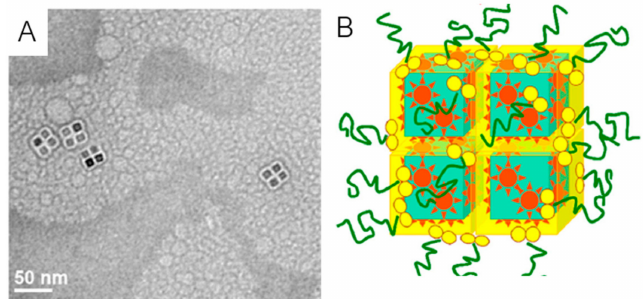
Figure 8. TEM image ( A ) and schematic representation ( B ) of Rubik-like paclitaxel-loaded magnetic nanoassemblies. Adapted from [151] with permission from Elsevier,